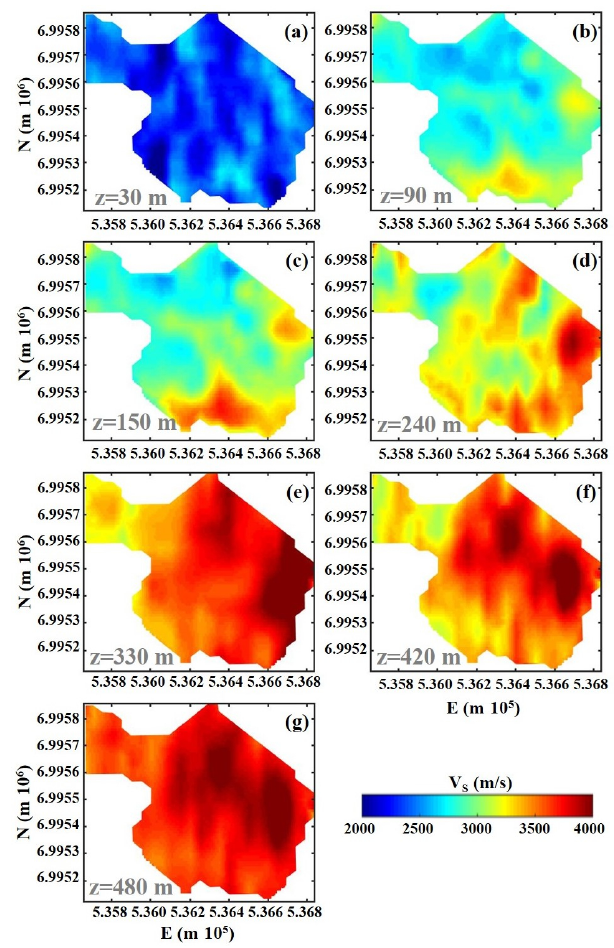
Figure 9. Final shear-wave velocity model obtained from ac- tive + passive SWT. Model slices at increasing depth: (a) 30m, (b) 90m, (c) 150m, (d) 240m, (e) 330m, (f) 420m, (g)